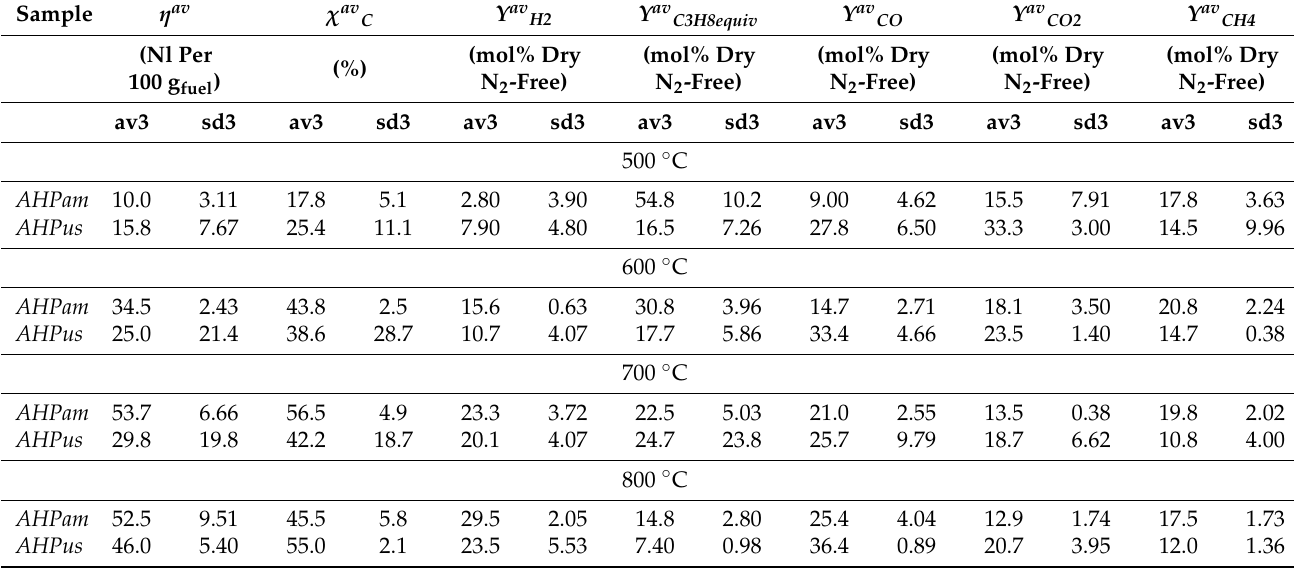
Table A1. Experimental results of devolatilization tests under nitrogen atmosphere, as functions of temperature (av3: average of results from the three individual pellets; sd3: standard deviation of results from the three individual pellets).